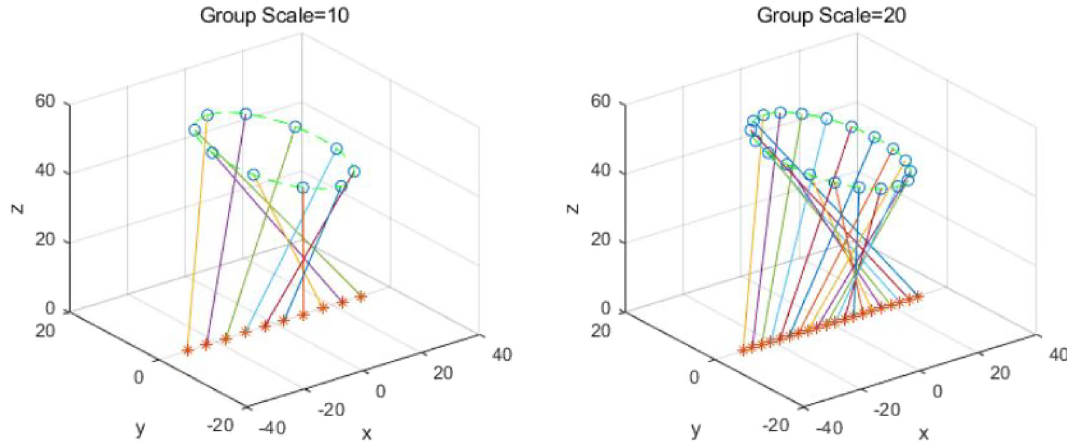
Fig. 18 Scenes of formation reconfiguration for muti-UAV formation of 10 scale and 20 scale